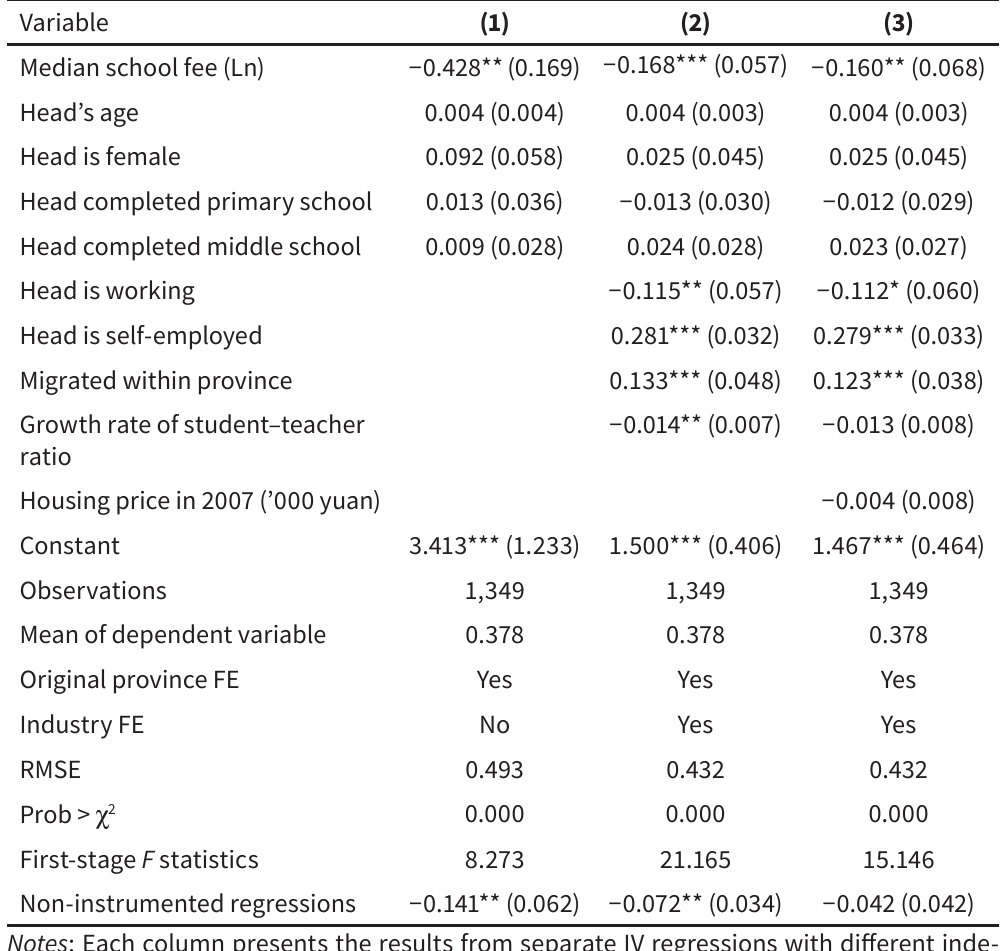
Table 2 Effects of median school fees on child migration, China